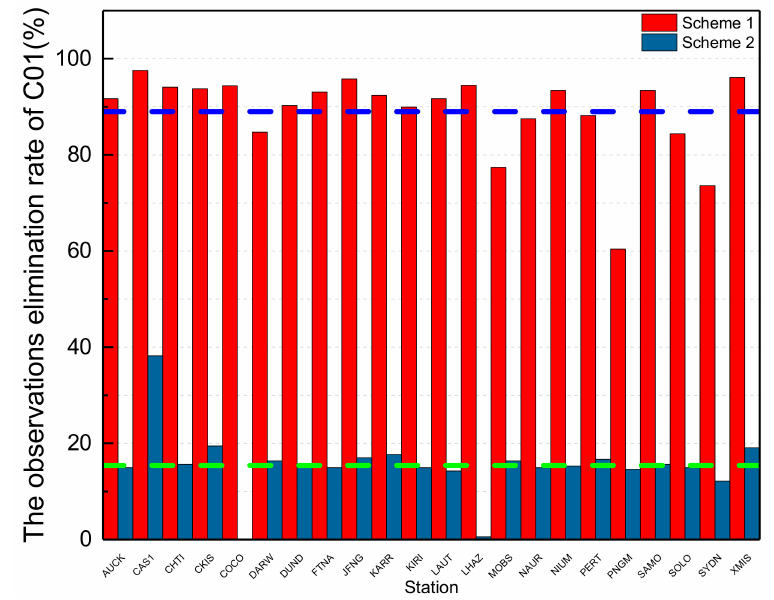
Figure 8. Observation elimination rate of stations for C01 from precise orbit determination on 9 January